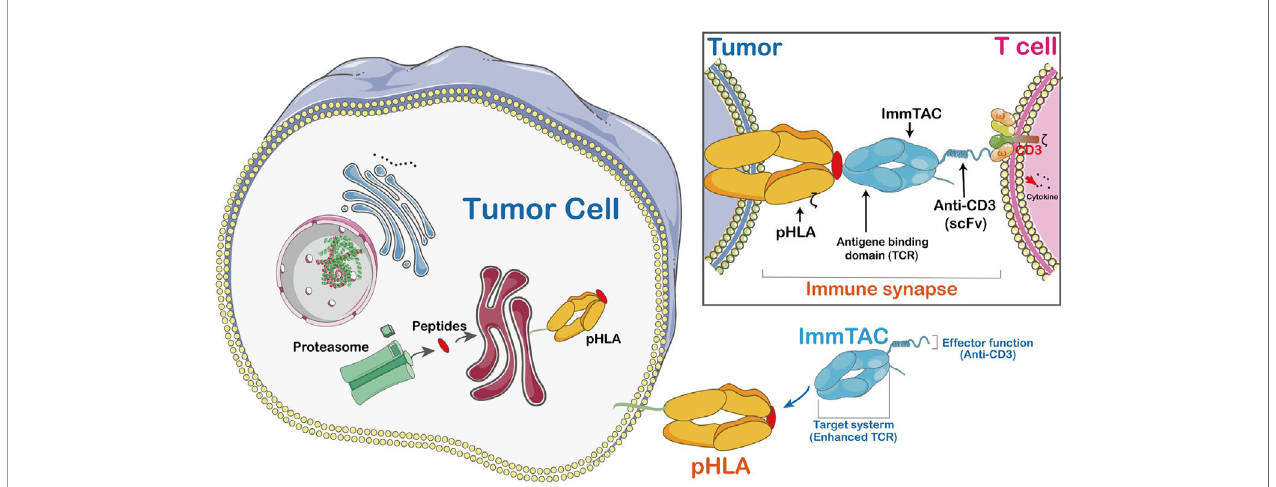
FIGURE 4 | The mechanism of ImmTAC action. ImmTACs are designed to activate T cells against cancer and virus-infected cells. ImmTAC is speci fi c to both MHC-peptides (pHLA) located on the surface of the tumor and CD3s located on T cells. The ImmTAC is able to directly activate CD3 and its corresponding pathways in activated T cells. In fact, the speci fi c role of CD4 and CD8 is to stabilize the immune synapse, an important process of T cells shortened and empowered by